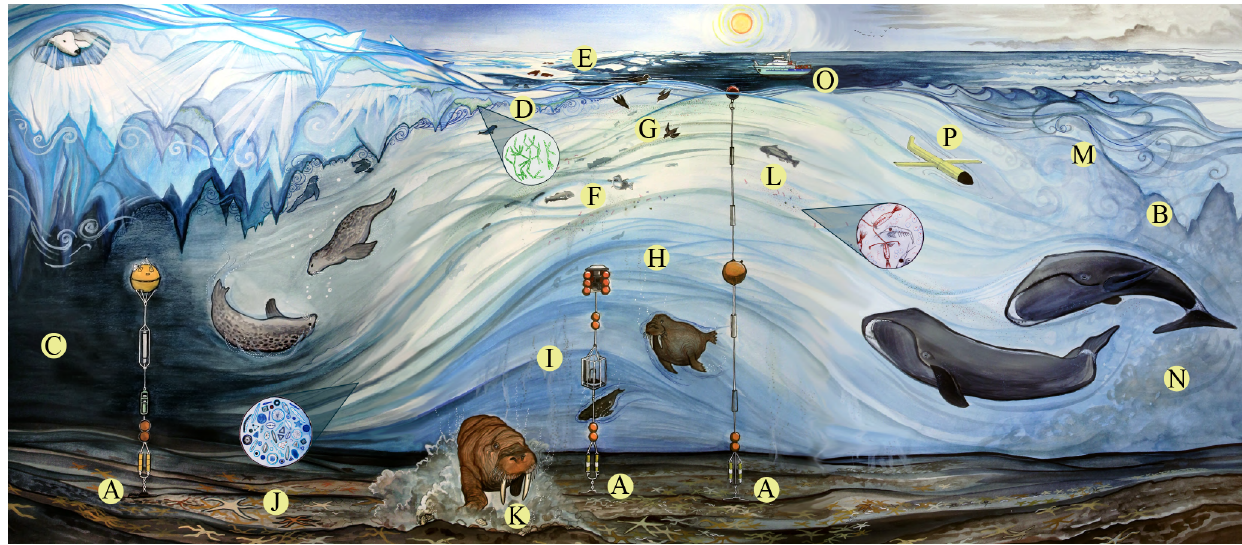
Figure 3. Illustration of the mooring array and the ecosystem at the observatory site. (A) Mooring array, (B) brine rejection, (C) dark winter, (D) sea ice algae bloom, (E) receding sea ice, (F) phytoplankton bloom, (G) stratification, (H) vertical gradient of nutrients and inorganic carbon, (I) sinking particulate organic matter, (J) rich benthic ecosystem, (K) foraging walrus, (L) Arctic cod, (M) storm-induced mixing, (N) senescent planktonic ecosystem, (O) Research Vessel Sikuliaq , and (P) glider. The illustration was painted by Klara Maisch. A high-resolution version can be downloaded from her personal website at https://klaramaisch.com/chukchi-sea-mooring-illustration (last access: 9 November 2018). Examples of walrus and bearded seal sounds are available at http://mather.sfos.uaf.edu/~seth/CEO/Sounds.html (last access: 9 November 2018). A movie describing the observatory in more detail is available at https://www.youtube.com/watch?v= ypmzTuAQ98k&feature=youtu.be (last access: 9 November